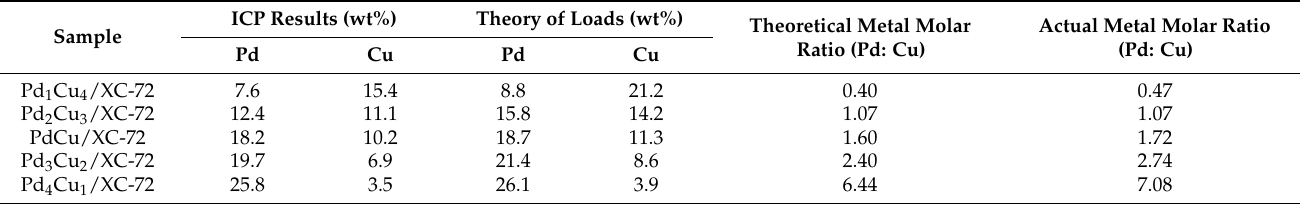
Table 1. ICP-OES results for PdxCuy/XC-72 catalysts.